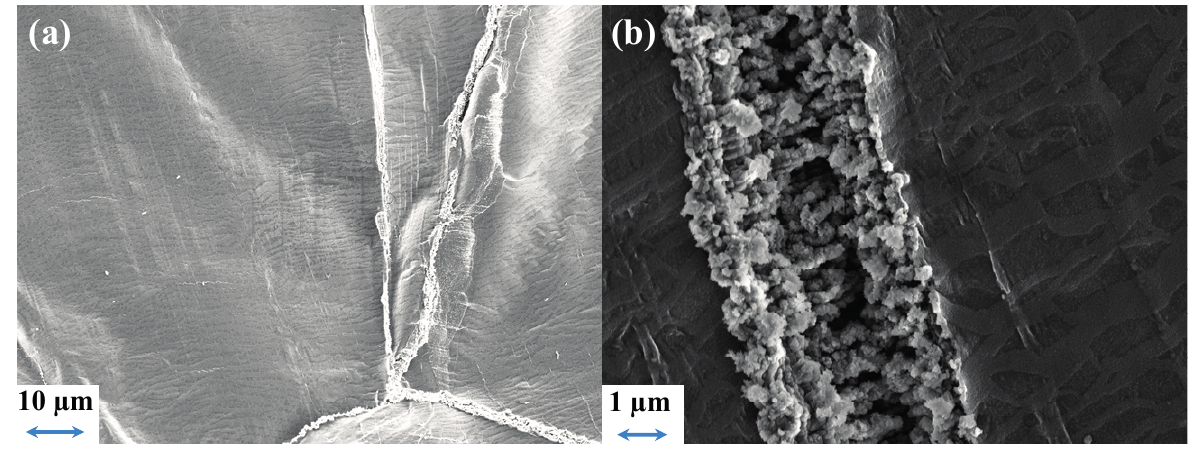
Figure 9. SEM images of the Li surface after 100 cycles, using a 10 mol% LiTFSI PYR TFSI and a Celgard ® 2325 separator. 14